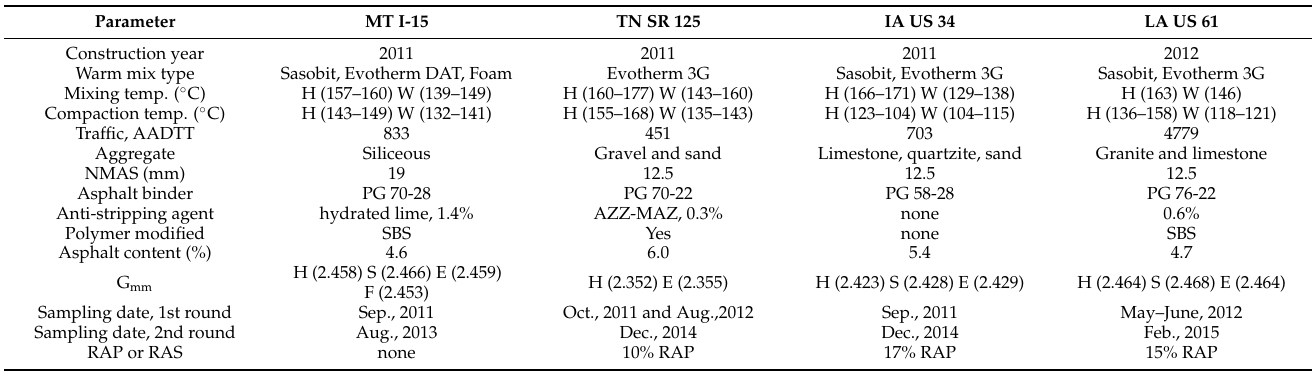
Table 1. Specimen Grading for Indoor Test.